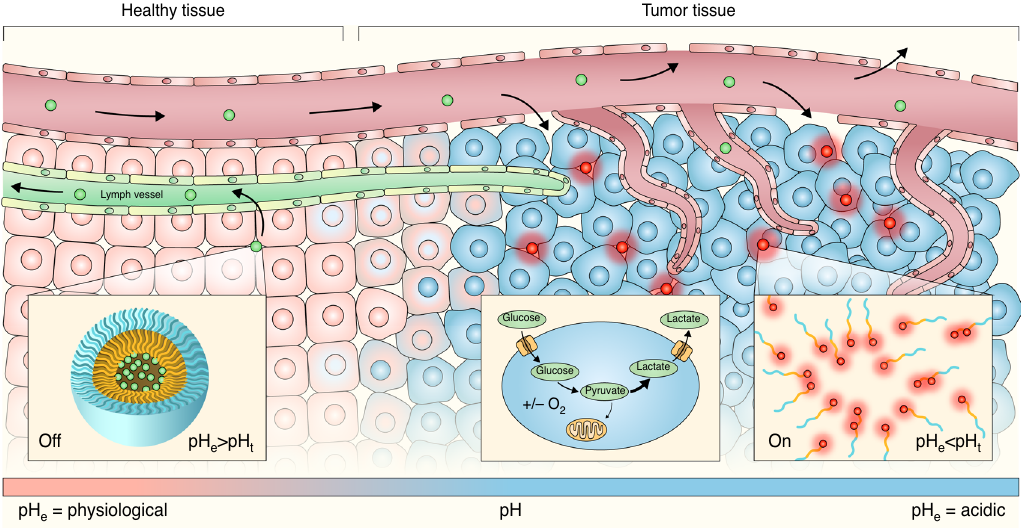
Fig. 1 Mechanism of action. A tumor microenvironment turns acidic when the tissue transforms from pre-malignant cells into invasive cancer. The ONM- 100 nanoparticles extravasate due to the enhanced permeability of the tumor vasculature and are then retained due to the poor lymph drainage in the tumor tissue. This leads to ONM-100 accumulation in the acidic extracellular matrix causing the pH activated fl uorescence to switch from the “ off ” (green) to the “ on ” (red) state. pH e : extracellular pH, pH t : threshold